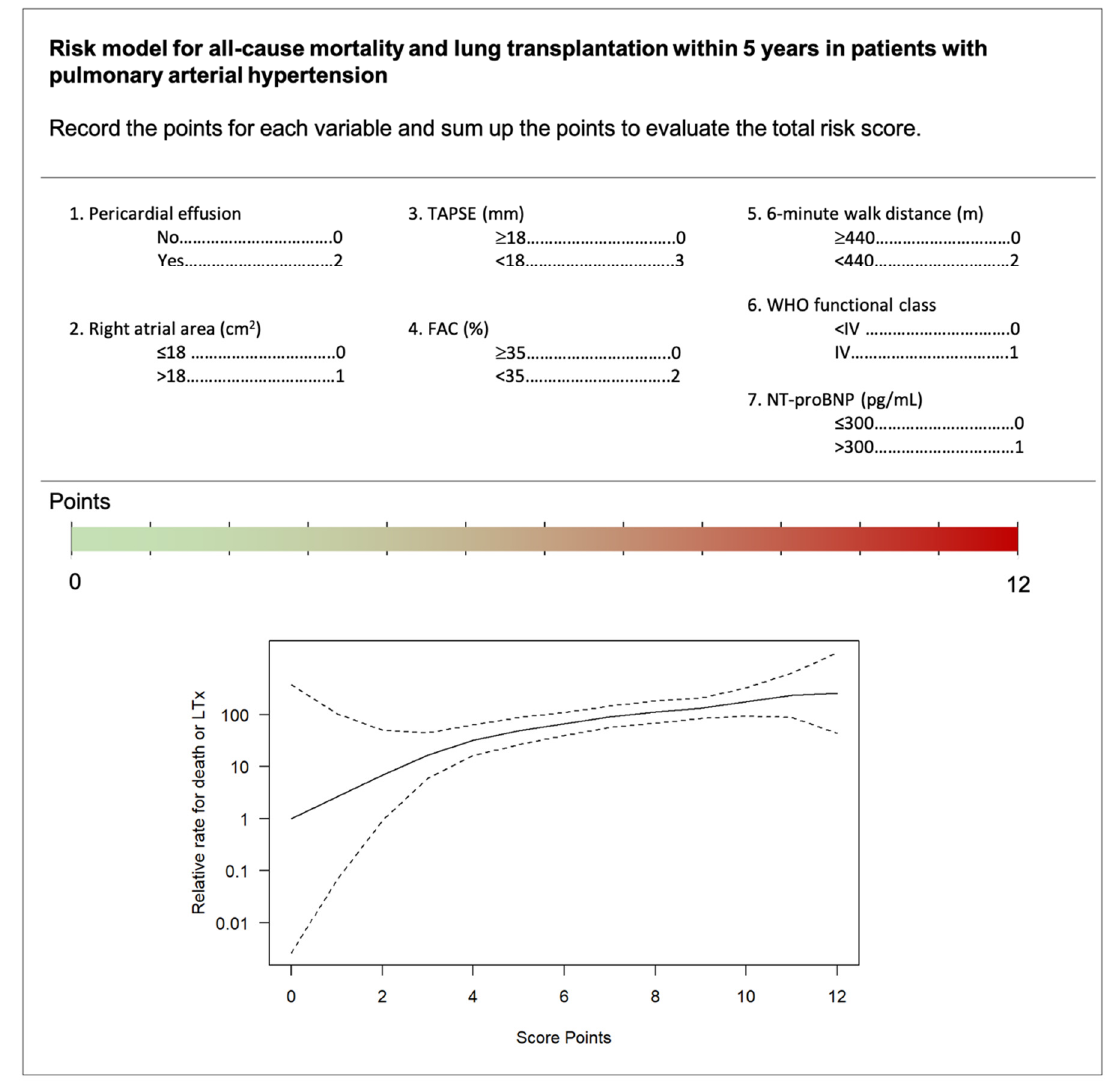
Figure 2. Point-based score to calculate the individual risk of all-cause mortality and lung transplantation within 5 years in patients with PAH. Legend: We developed a point-based score to assess the risk of death or lung transplantation within 5 years in patients with pulmonary arterial hypertension. The score ranges from 0 to 12 points and indicates the relative risk. Abbreviations: TAPSE = tricuspid annular plane systolic excursion, FAC = fractional area change, NT-proBNP = N-terminal-pro hormone brain peptide, LTx = lung transplantation